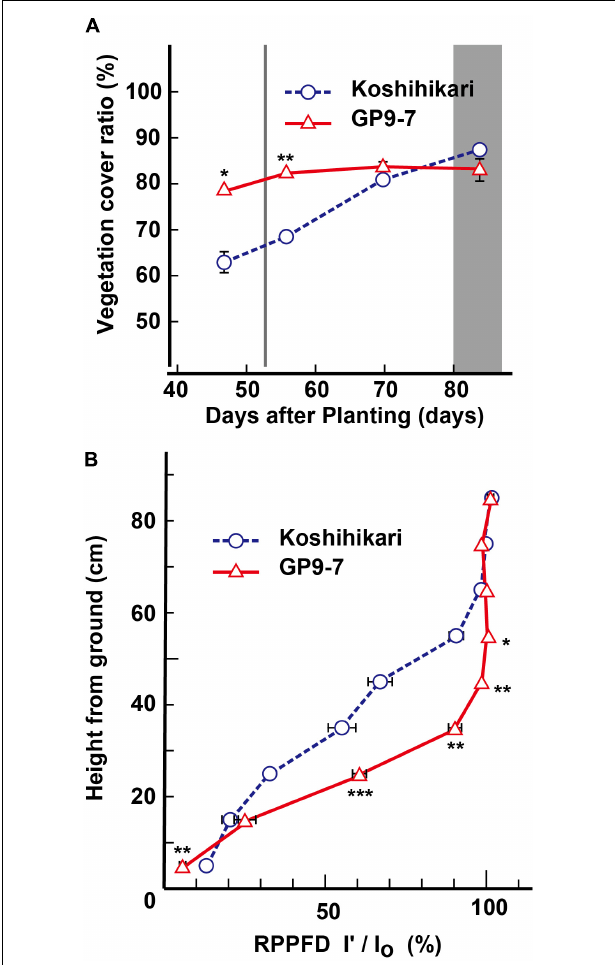
FIGURE 4 | Light reception-related properties of GP9-7. (A) Developmental transitions in vegetative coverage of Koshihikari and GP9-7 in the test field at Tsukuba, Japan in the summer of 2018 (planting date: May 28, 2018). The period for heading is indicated by a vertical gray bar. This analysis was performed according to Materials and Methods, using images continuously taken at the same three points in the field, and the mean values with SE were indicated in the graph. (B) Vertical transitions of the relative photosynthetic photon flux density (RPPFD) of Koshihikari and GP9-7 measured on the 52nd DAP that is shown by a vertical gray line in panel (A) . Symbols, ***, **, and * indicate statistically significant differences compared to Koshihikari at P < 0.001, P < 0.01, and P < 0.05, respectively, calculated by the Welch’s t -test. Values for Koshihikari are indicated with blue circles with broken lines and values for GP9-7 are represented with red triangles with solid lines.